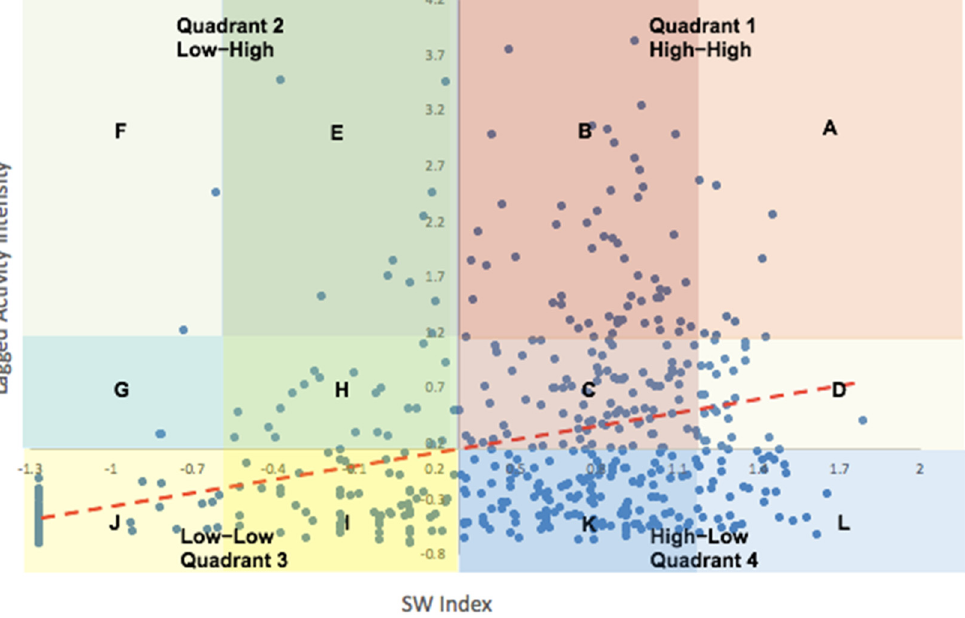
Figure 11. Global Moran’s I of service facility diversity and population activity intensity. Note: The uppercase letters represent the spatial match type.